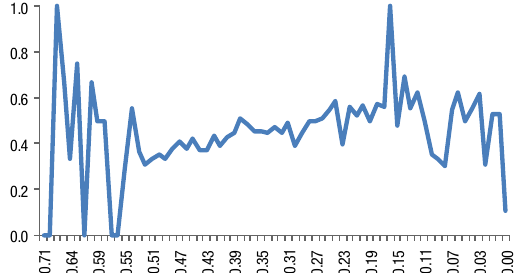
Fig. A.4. Relationship between the probability of increasing the cash exposure ( p ( t ) values) and the previous cash weight ( β